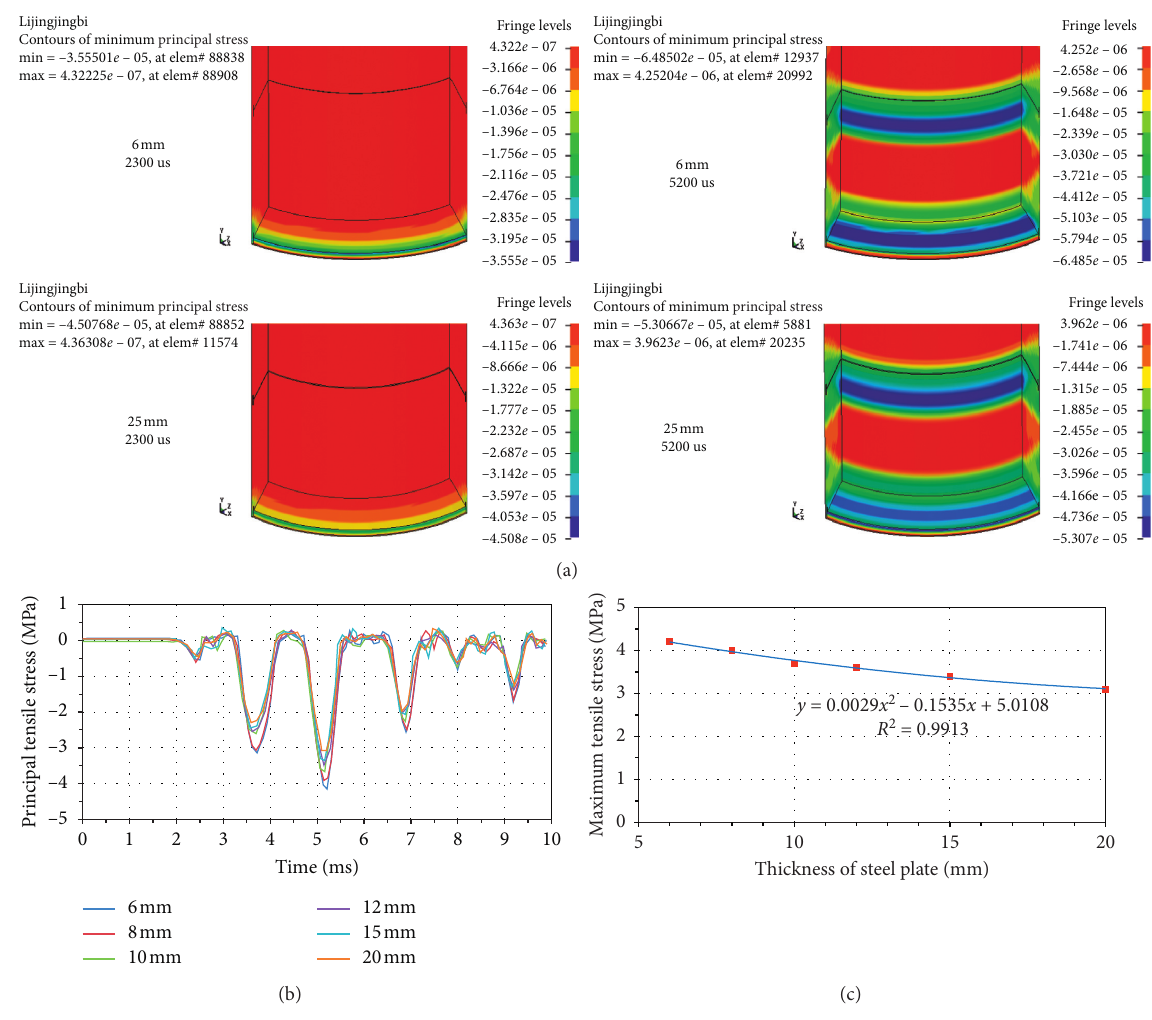
Figure 8: Tensile stress curve corresponding to different steel plate thickness. (a) Nephogram of the principal tensile stress at the center of the steel plate. (b) Principal tensile stress curves with different steel plate thickness. (c) Maximum tension stress corresponding to different steel plate thickness.